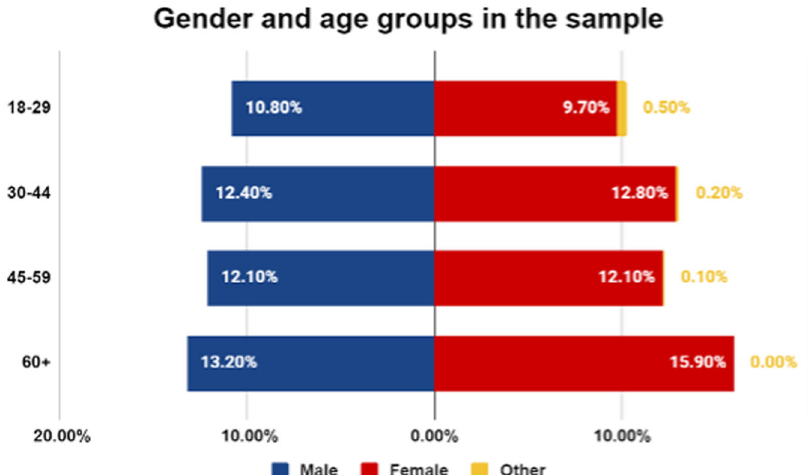
Fig. 11 The proportion of participants in each gender and age group category. As shown, we recruited a representative sample based on age/gender groups.